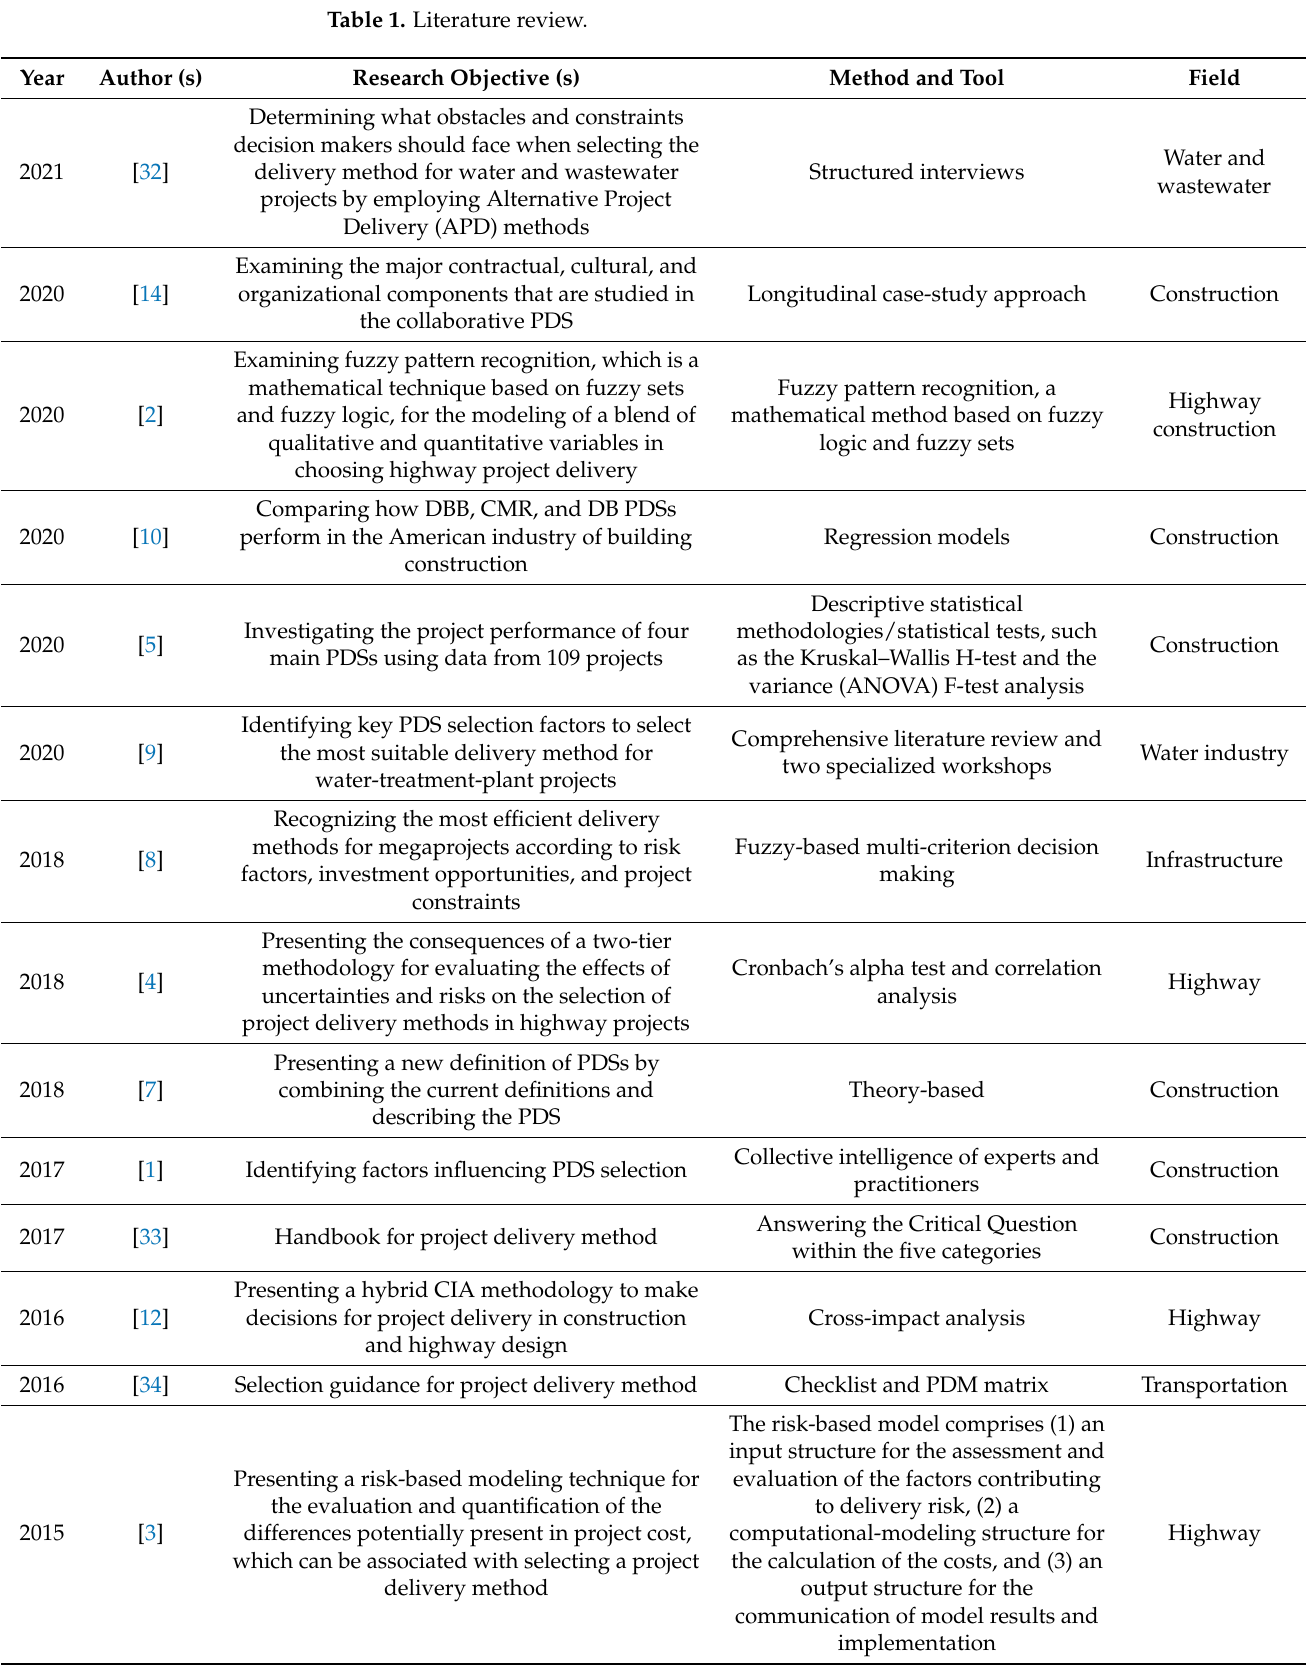
Table 1. Literature